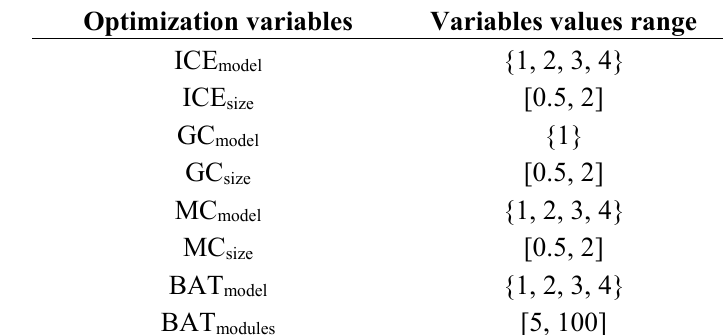
Table 6. Optimization variables for each vehicle powertrain configuration: components design and